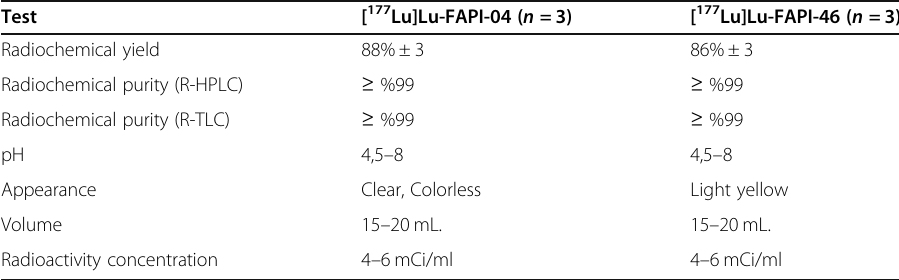
Table 4 The final product specifications for [ 177 Lu]Lu-FAPI-04 and [ 177 Lu]Lu-FAPI-46 (n = 3, 100 mCi, [ 177 Lu] Lu & 100 μ g of FAPI derivatives) Test